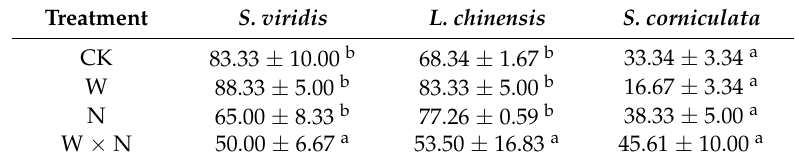
Table 1. The colonization status (%) of arbuscular mycorrhizal fungi (AMF) treatment under warming (W) and N input (N). CK, control; N, N input; W, warming; W × N, combination of warming and N input.